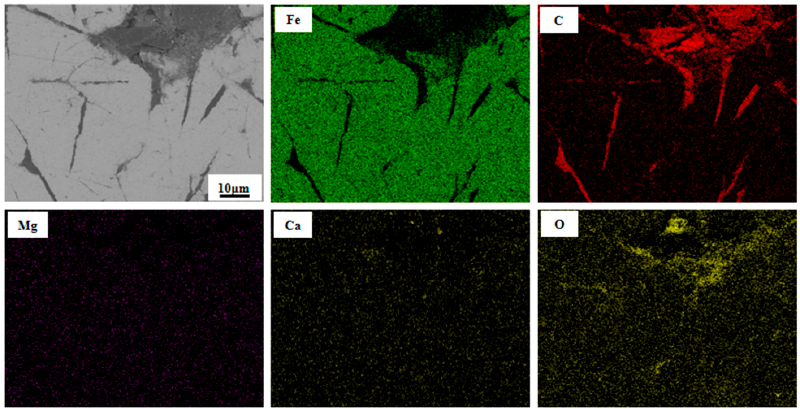
Metals 2019 , 9 , 510 Figure 20. SEM and element mapping images of Fe, C, Mg, Si, and O for 2.0 wt% MgO sinter.